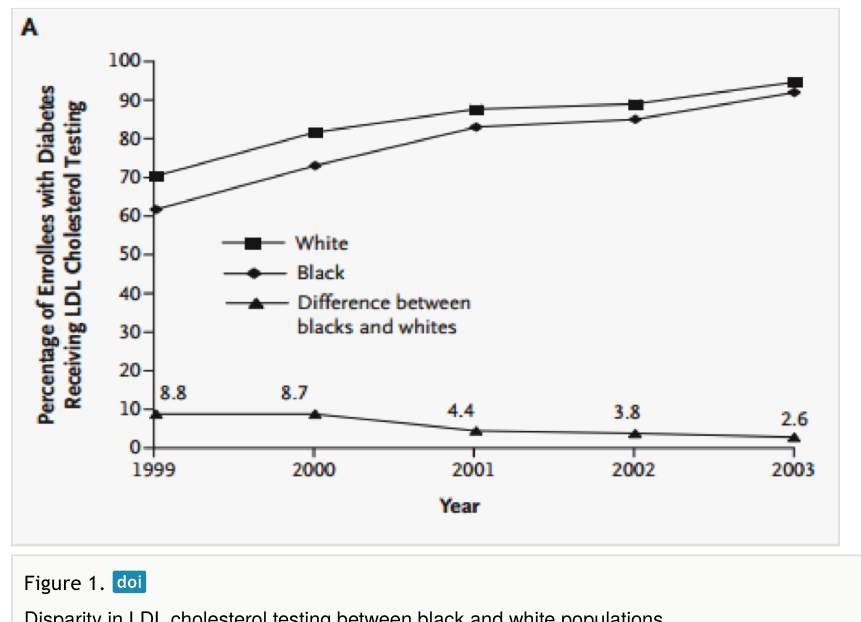
Disparity in LDL cholesterol testing between black and white